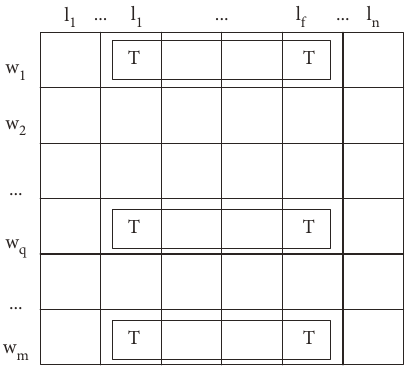
Figure 6: A schematic diagram of the collaborative filtering